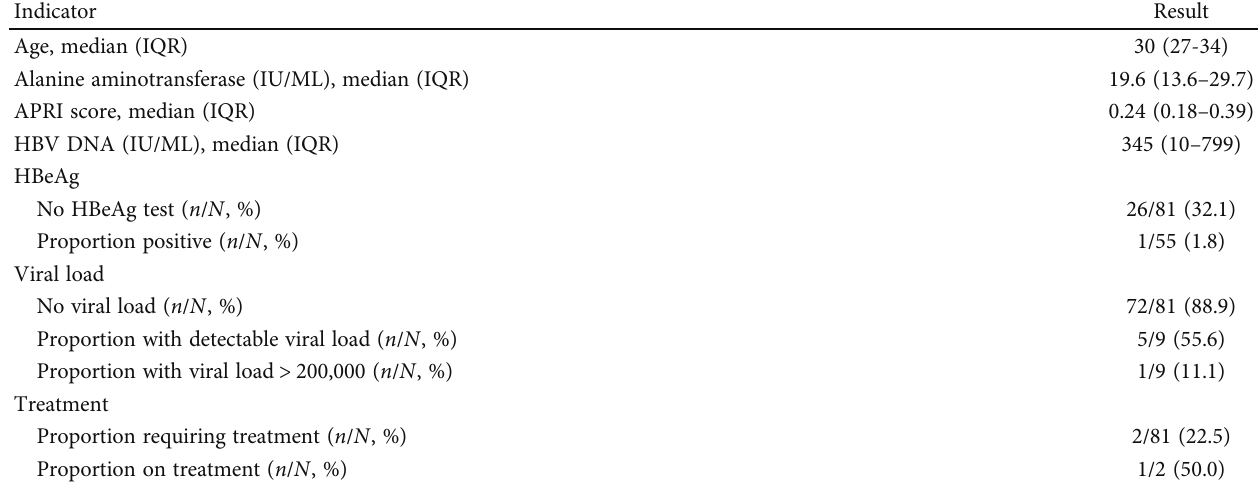
Table 3: Summary of characteristics of pregnant women with chronic HBV infection ( n = 81 ).